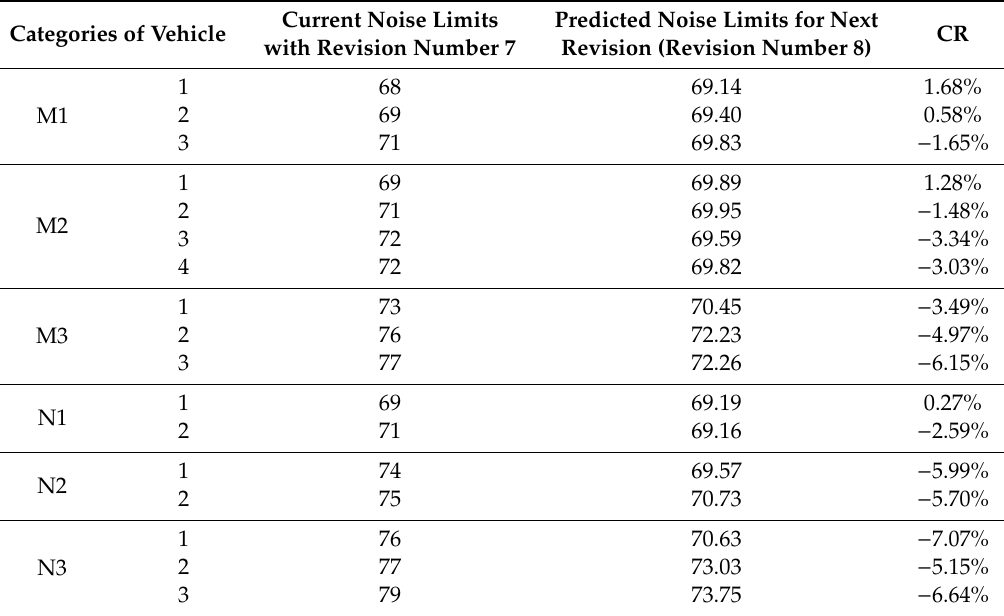
Table 6. Predicted values by using the proposed BPNN